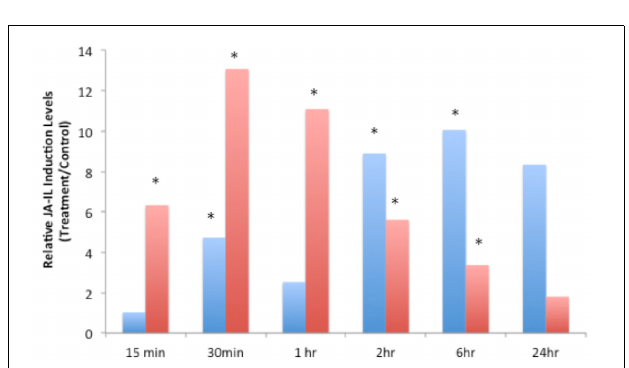
FIGURE 3 | Relative Jasmonic-isoleucine (JA-IL) Acid levels in WT Arabidopsis plants after S. exigua and P. rapae feeding over a 24-h time course-JA-IL was measured by UPLC-MS/MS as pmol/g fresh weight. Blue bars represent JA-IL levels in S. exigua treatments/controls. Red bars in represent JA-IL levels in P. rapae treatments/controls. Asterisks represent time points where JA-IL levels in the treatment plants was significantly greater than controls as determined by the GLM method in SAS ( p < 0 .